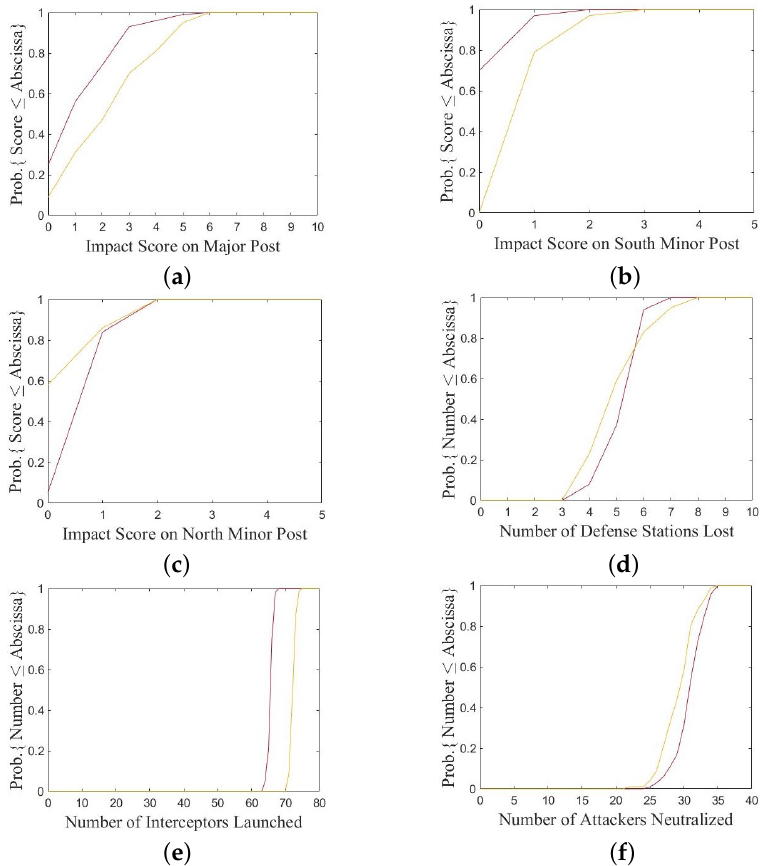
Figure 21. CDF of ( a ) impact score on major post; ( b ) impact score on south post; ( c ) impact score on north post; ( d ) number of lost defense stations; ( e ) number of launched interceptors; ( f ) number of lost attackers, against slant attack formation (brown) or pincer attack formation